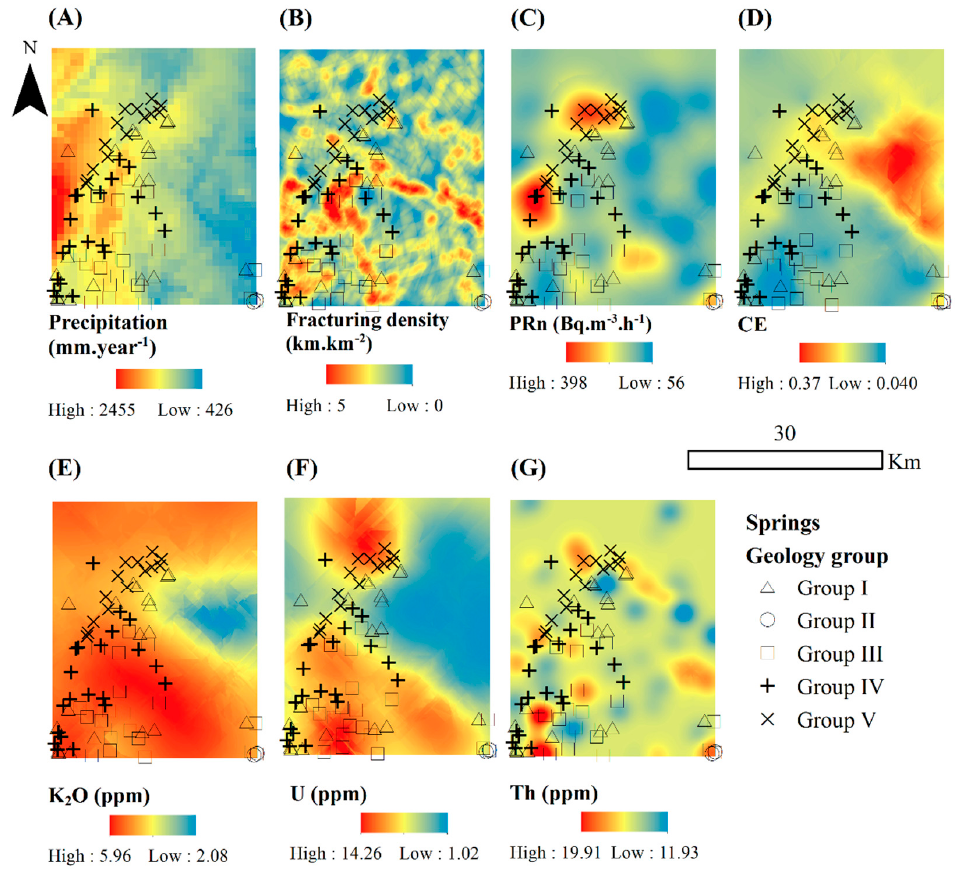
Figure 5. The geogenic, dilution and migration features maps with rating scores used for input data for PLS-PM analysis: ( a ) precipitation, ( b ) fracturing density, ( c ) radon production potential (PRN), ( d ) emanation coefficient, ( e ) K 2 O contents, ( f ) U contents and ( g ) Th contents.